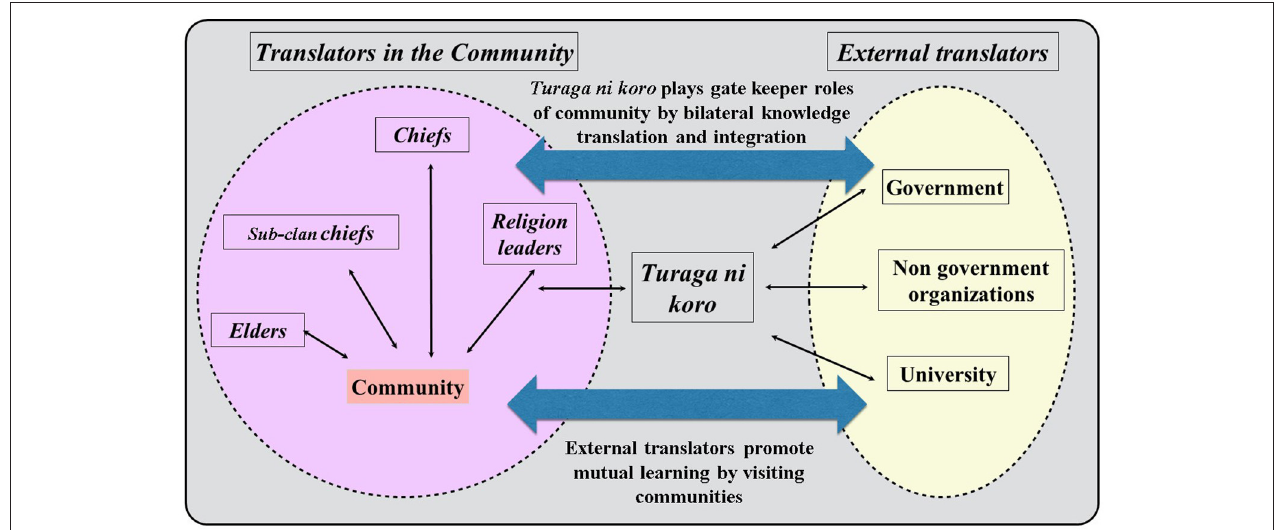
FIGURE 5 | Network of knowledge translators and the roles of turaga ni koro in Kumi Village (see text for